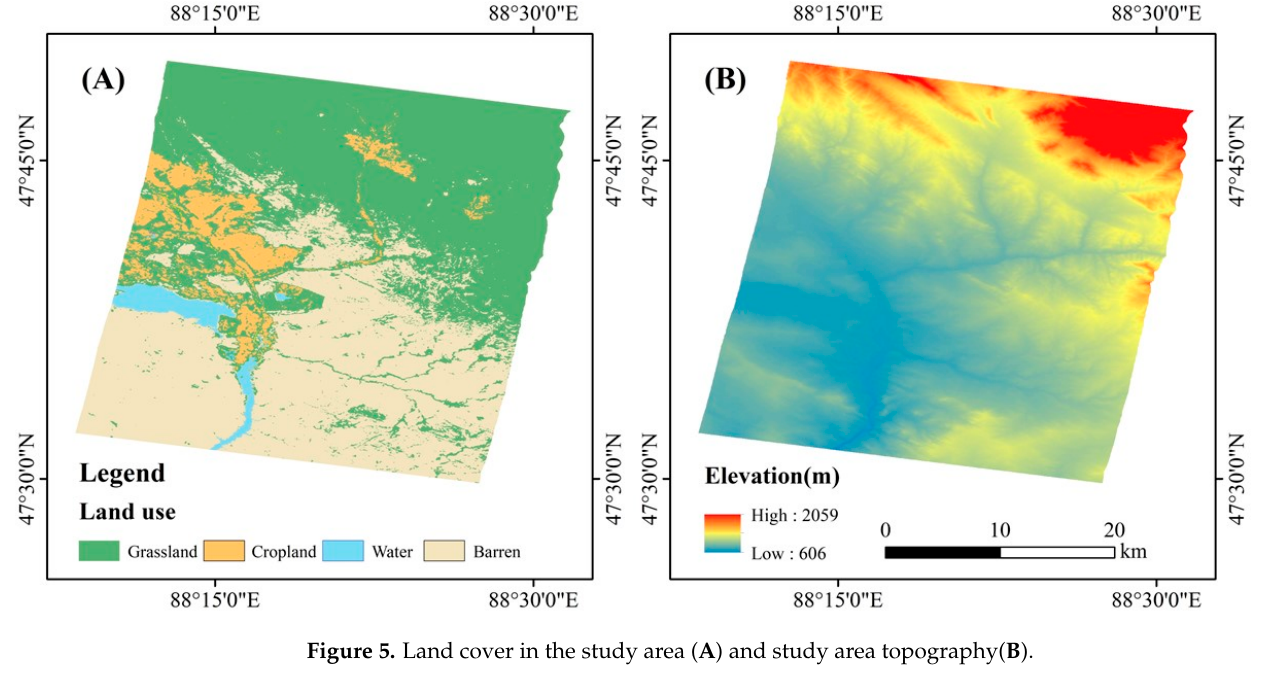
Figure 5. Land cover in the study area ( A ) and study area topography( B ).